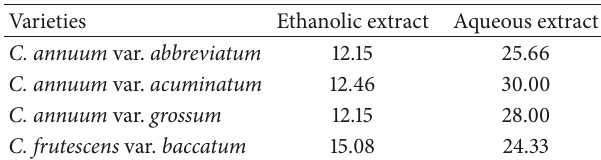
Table 1: Percentage yields of the four varieties of cultivated Cap- sicum species after